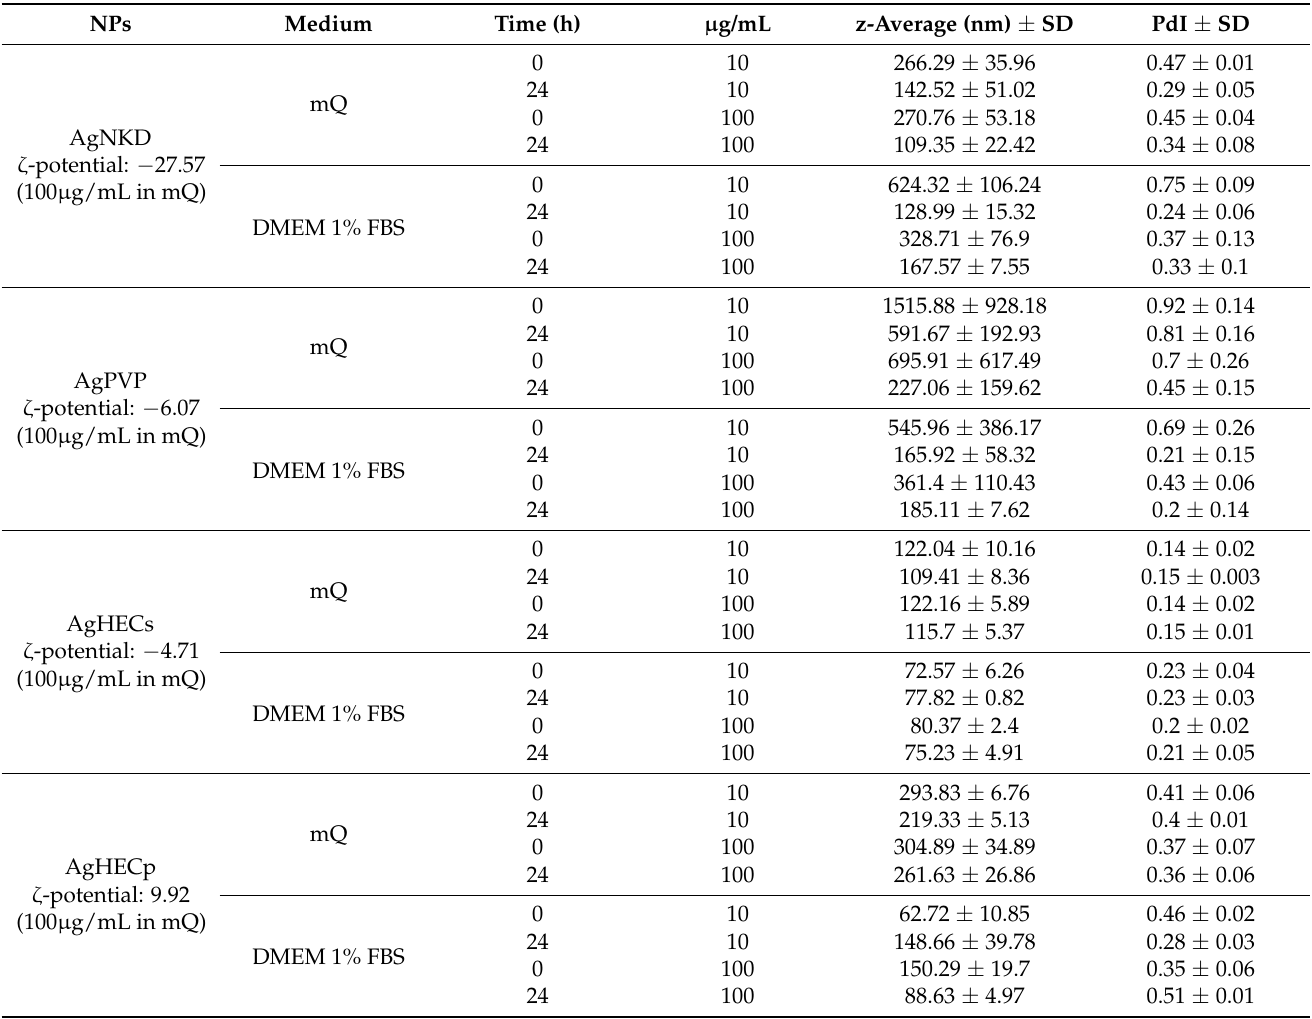
Table 1. Ag NP characterization for cell exposure. Dynamic Light Scattering (DLS) analysis performed for Ag NPs (AgNKD, AgPVP, AgHECs and AgHECp) in MilliQ water and cell culture medium (CCM). The measurements were performed at two different time points, 0 and 24 h, and two concentrations (10 and 100 µ g/mL) were considered. In the table are also reported the values of z-average (nm) ± SD and PDI ± SD. In addition, for each particle is indicated the value ζ -potential (mV) in MilliQ water at the concentration of 100 µ